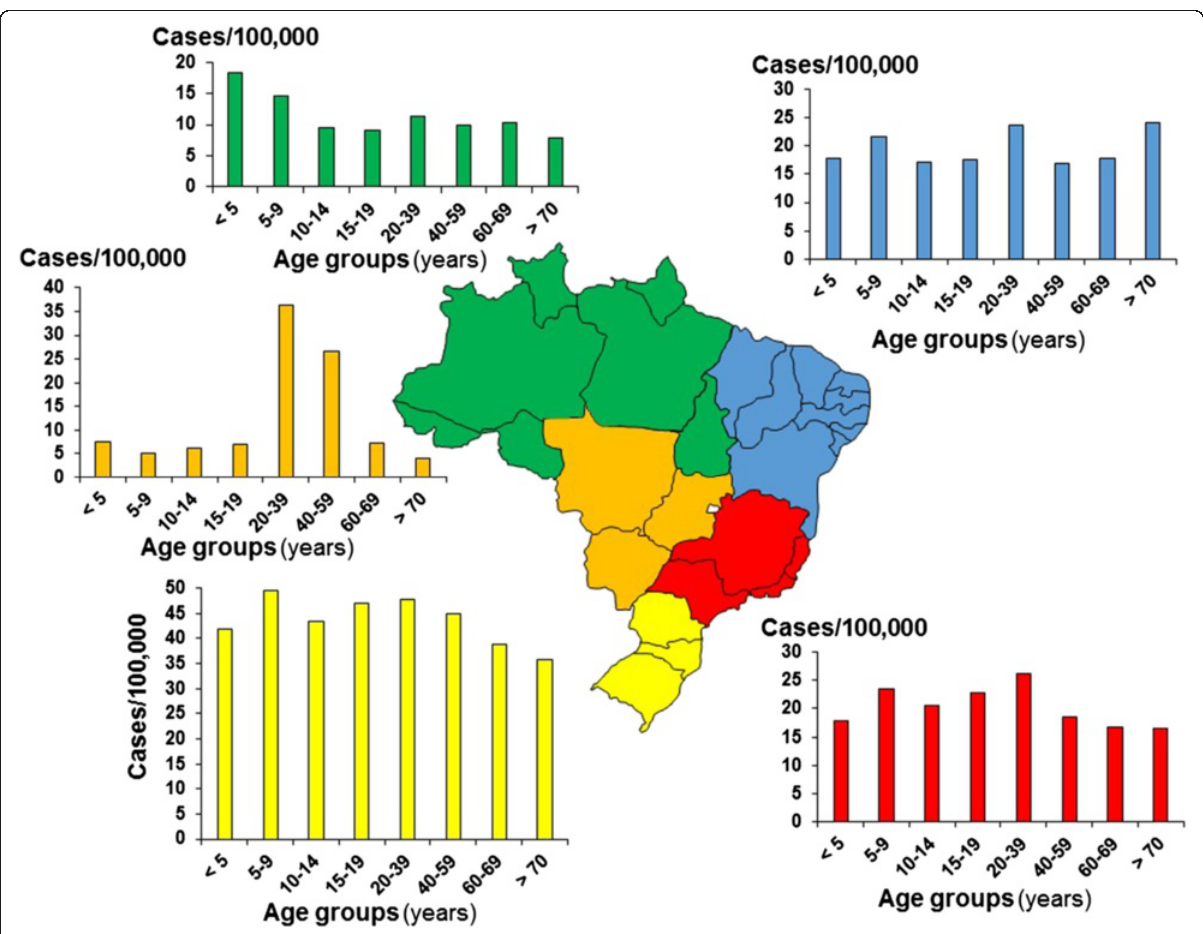
Fig. 7 Age-specific spider bite incidence (per 100,000 people) in Brazil according to age group and